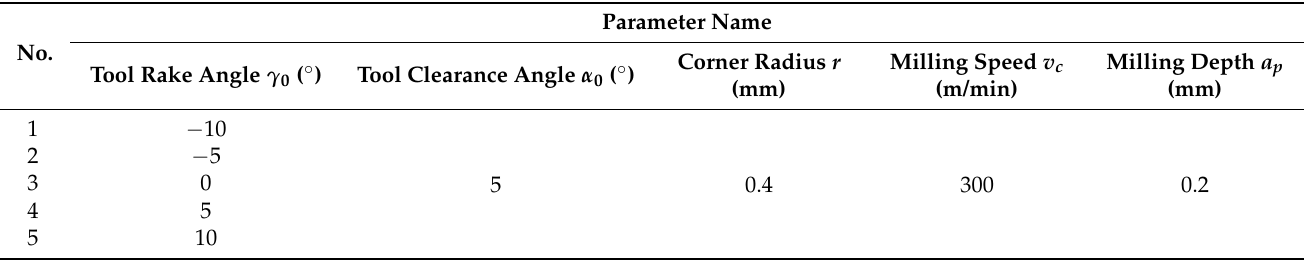
Table 5. Single-factor analysis plan for different tool rake angles.